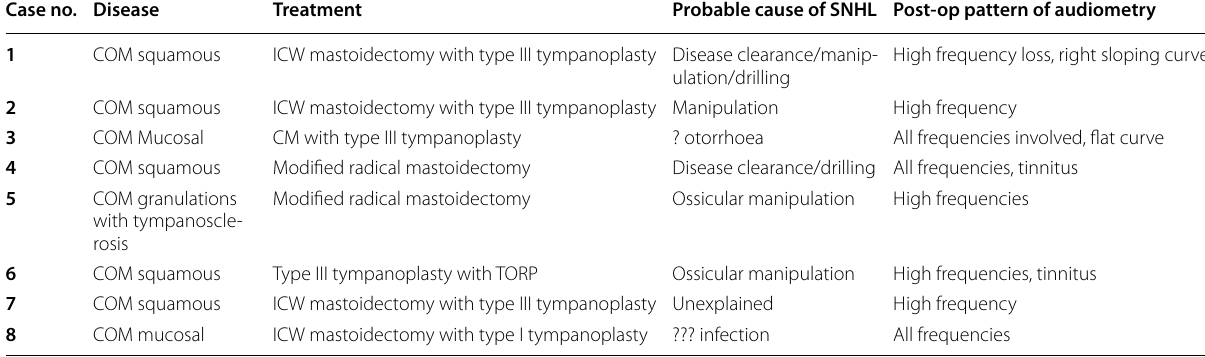
Table 3 Probable cause of SNHL and pattern of audiogram Case no. Disease